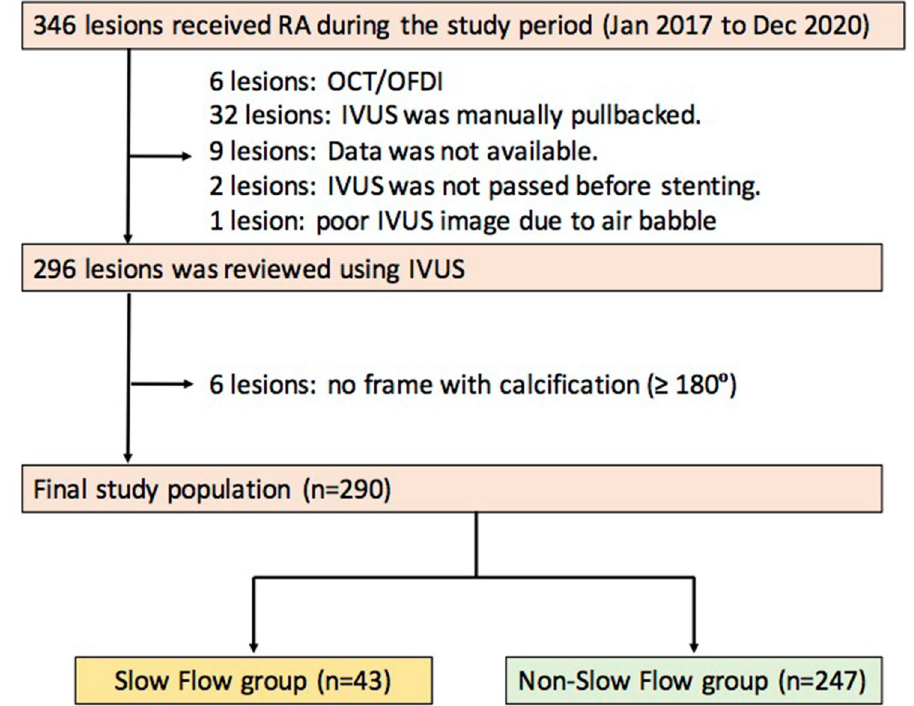
Figure 2. Study flow chart. IVUS intravascular ultrasound, OCT optical coherence tomography, OFDI optical frequent domain imaging, RA rotational